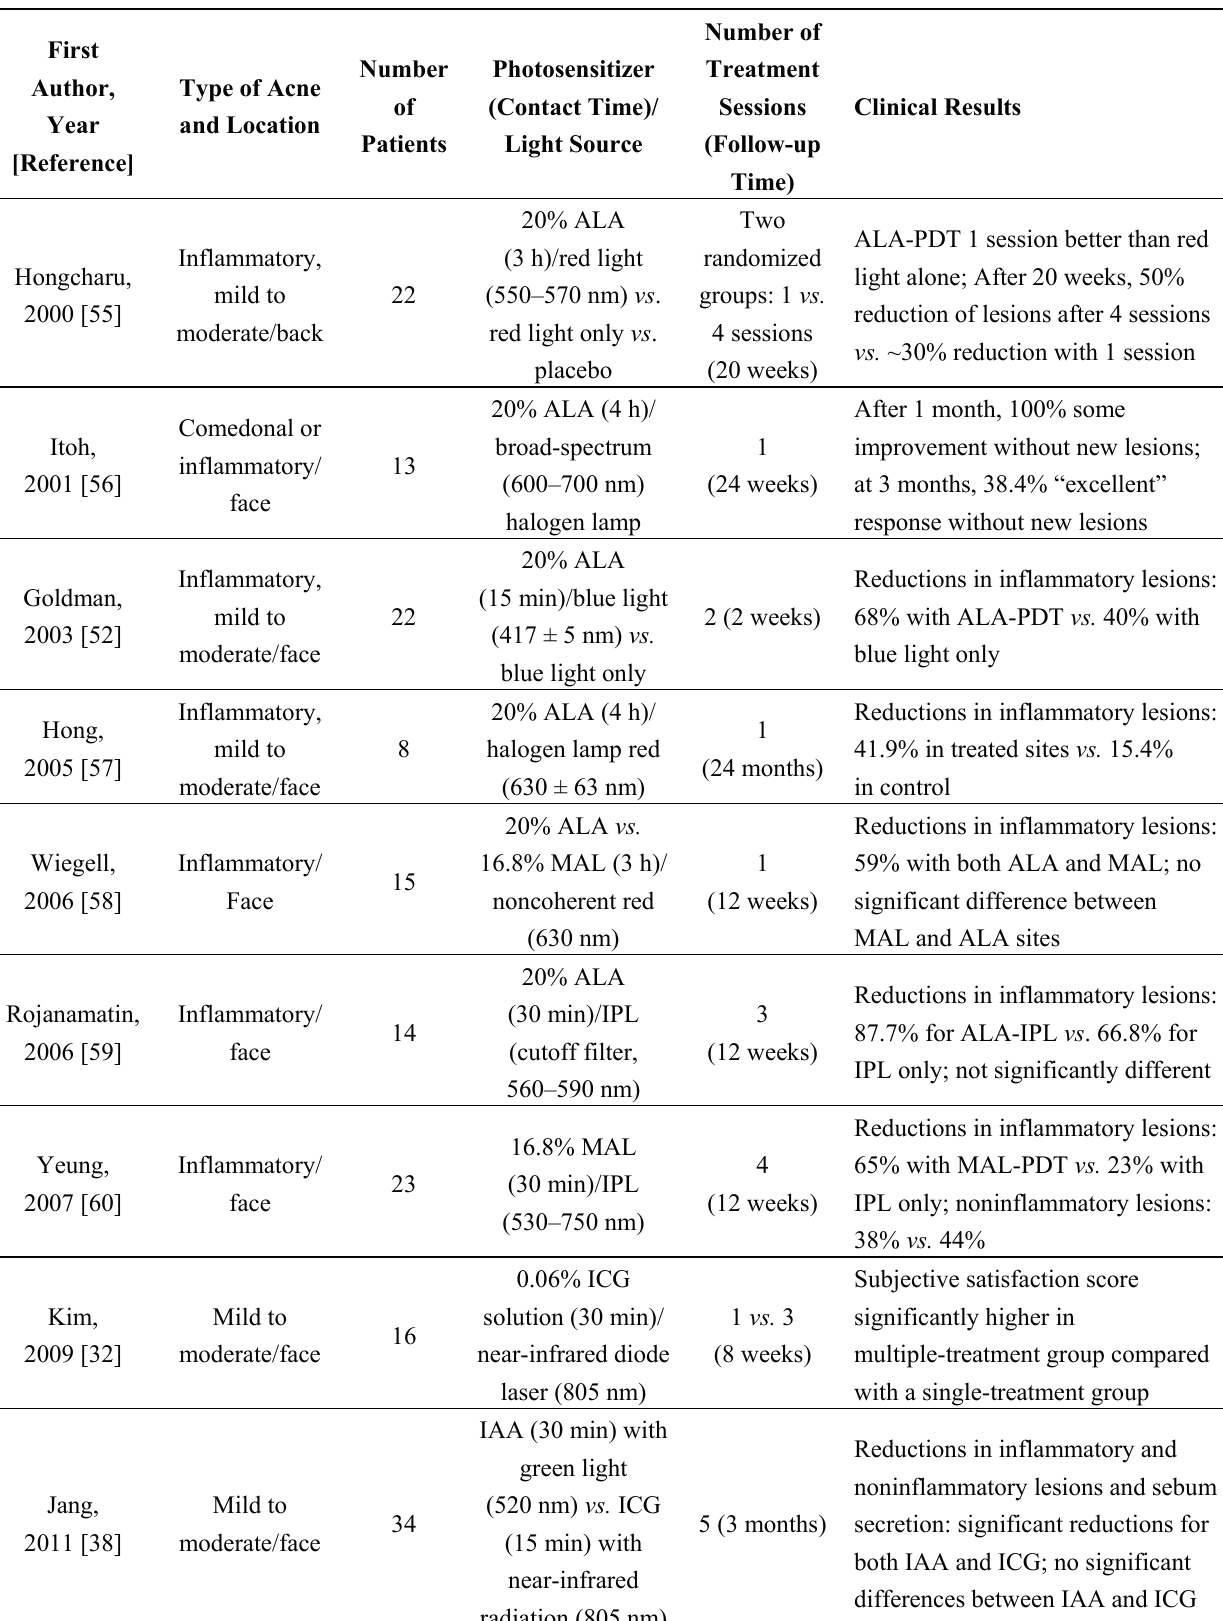
Table 1. Clinical studies of topical PDT for the treatment of acne